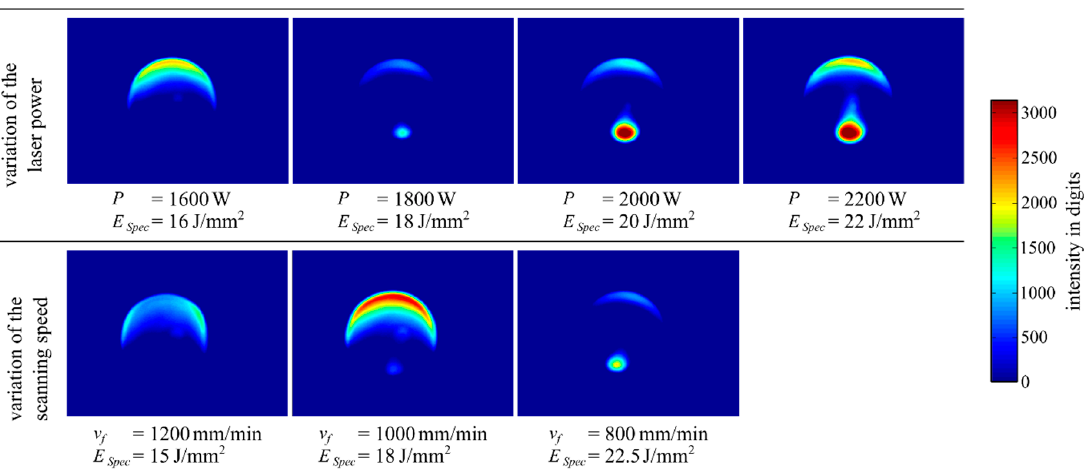
Figure 12. The averaged intensity distributions showing a growing expression of the plasma plume as the laser power increased and the scanning speed decreased.